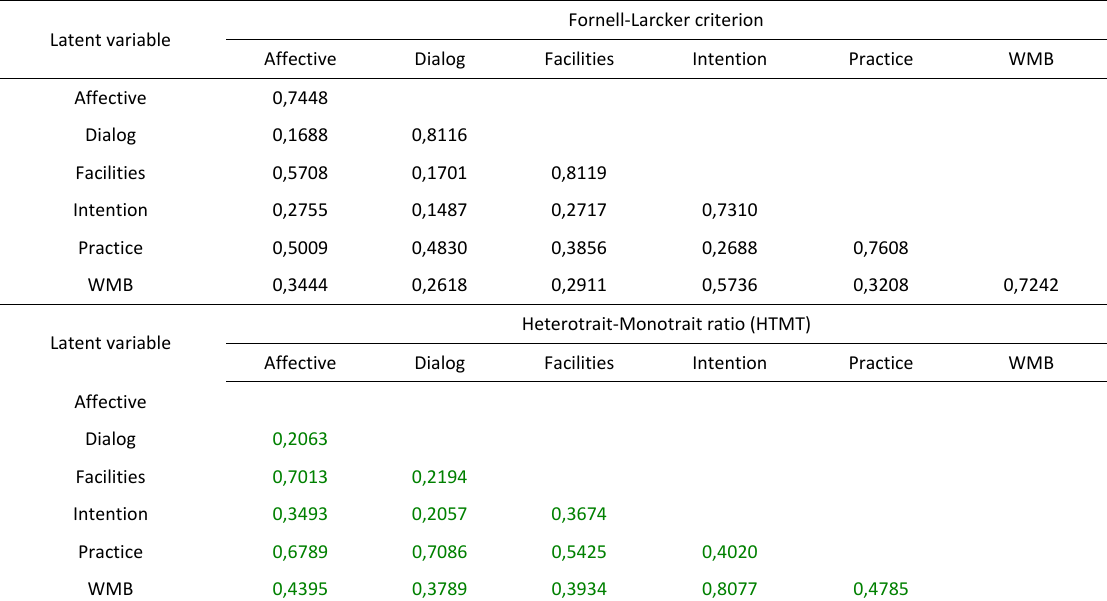
Table 7: The final discriminant validity of the outer model